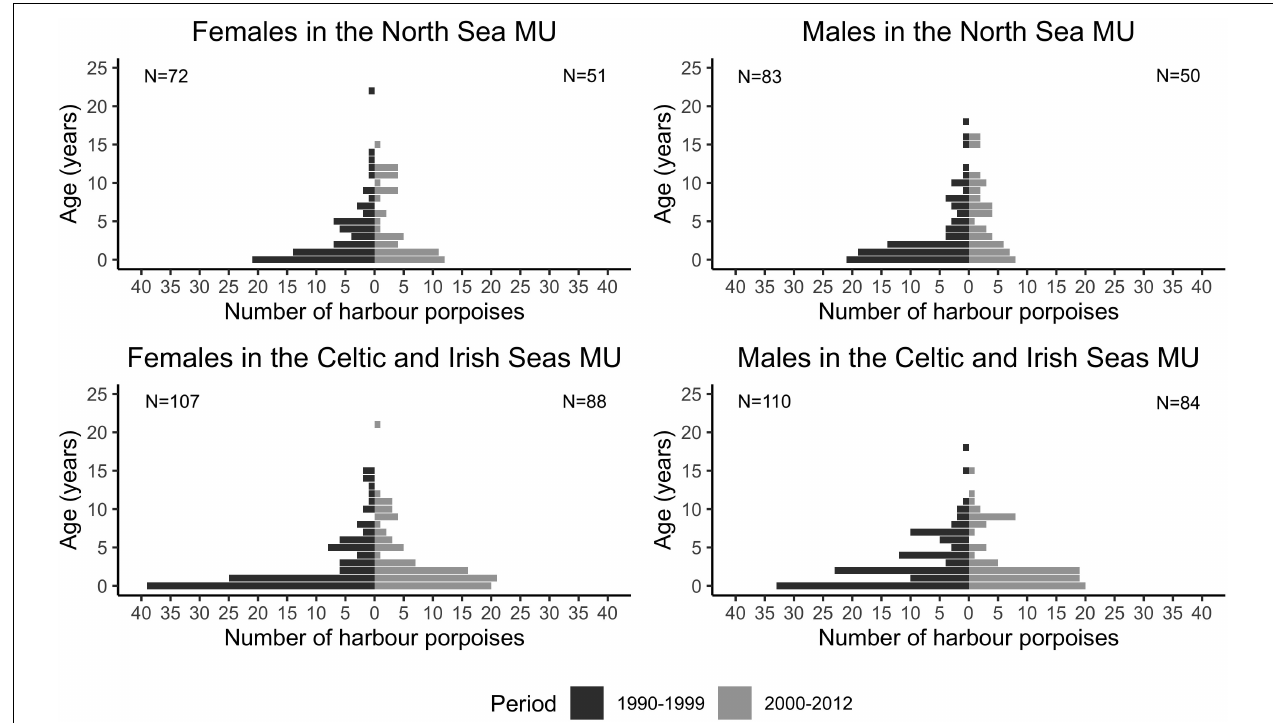
FIGURE 2 | Age-frequency distribution and sample sizes of female and male harbor porpoises sampled within the North Sea MU and Celtic and Irish seas MU during the two time periods, 1990–1999 and